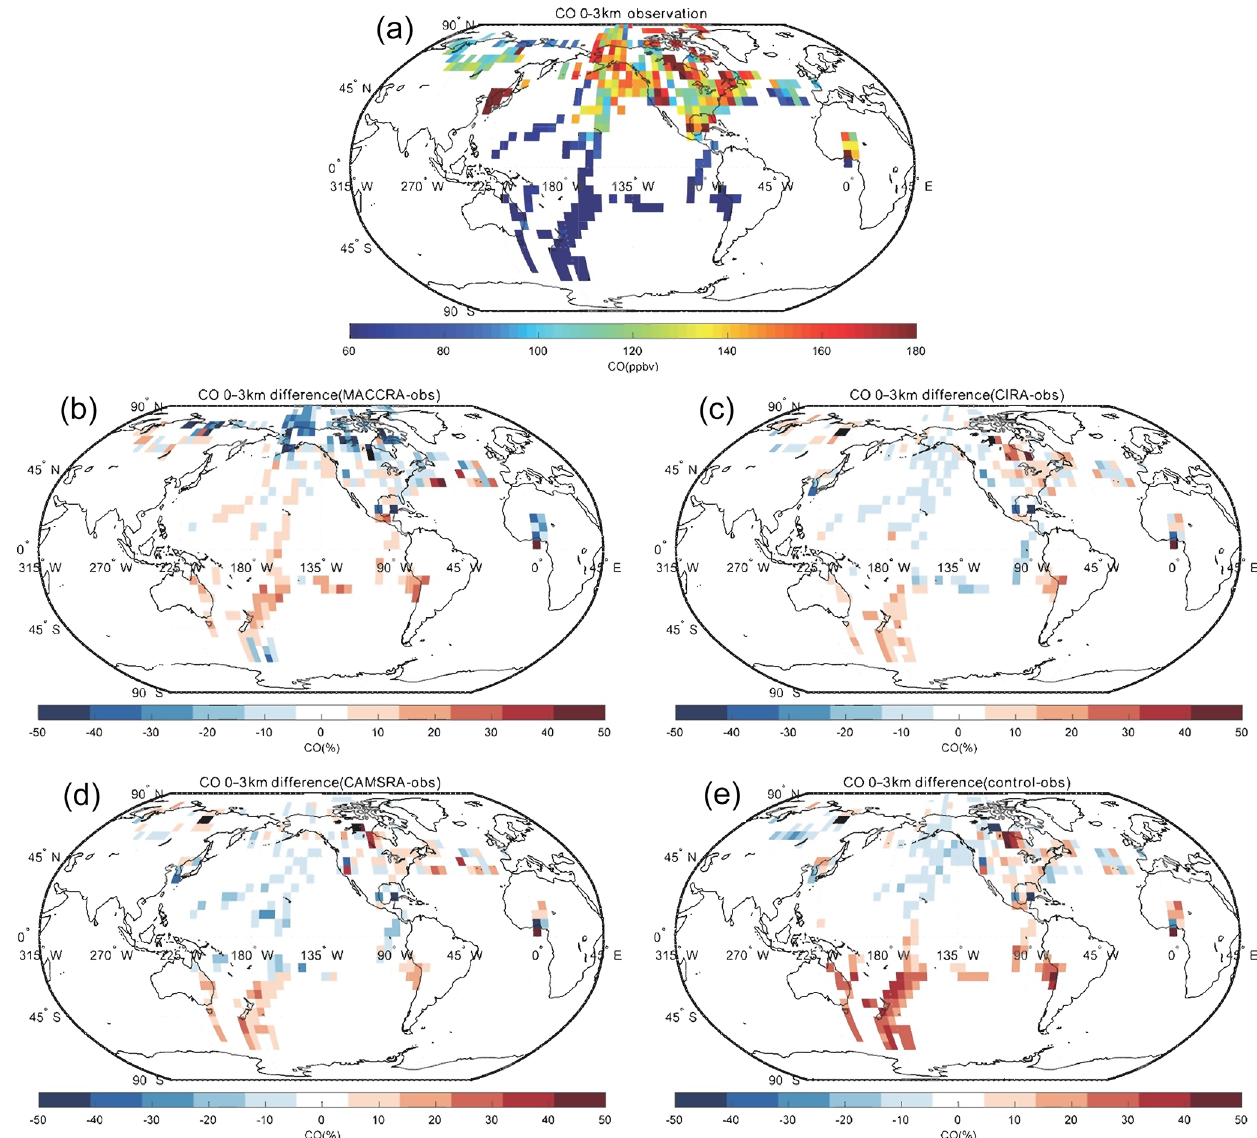
Figure 5. Campaign observations of CO (a) . (b) The relative difference in percent between MACCRA and the observations (MACCRA – observation). (c) The difference between CIRA and the observations (CIRA – observation). (d) The difference between CAMSRA and the observations (CAMSRA – observation), and (e) the difference between the control run and the observation (control – observation). The data are averaged to 5 ◦ × 5 ◦ (latitude × longitude) and to the altitude bin of 0–3km.